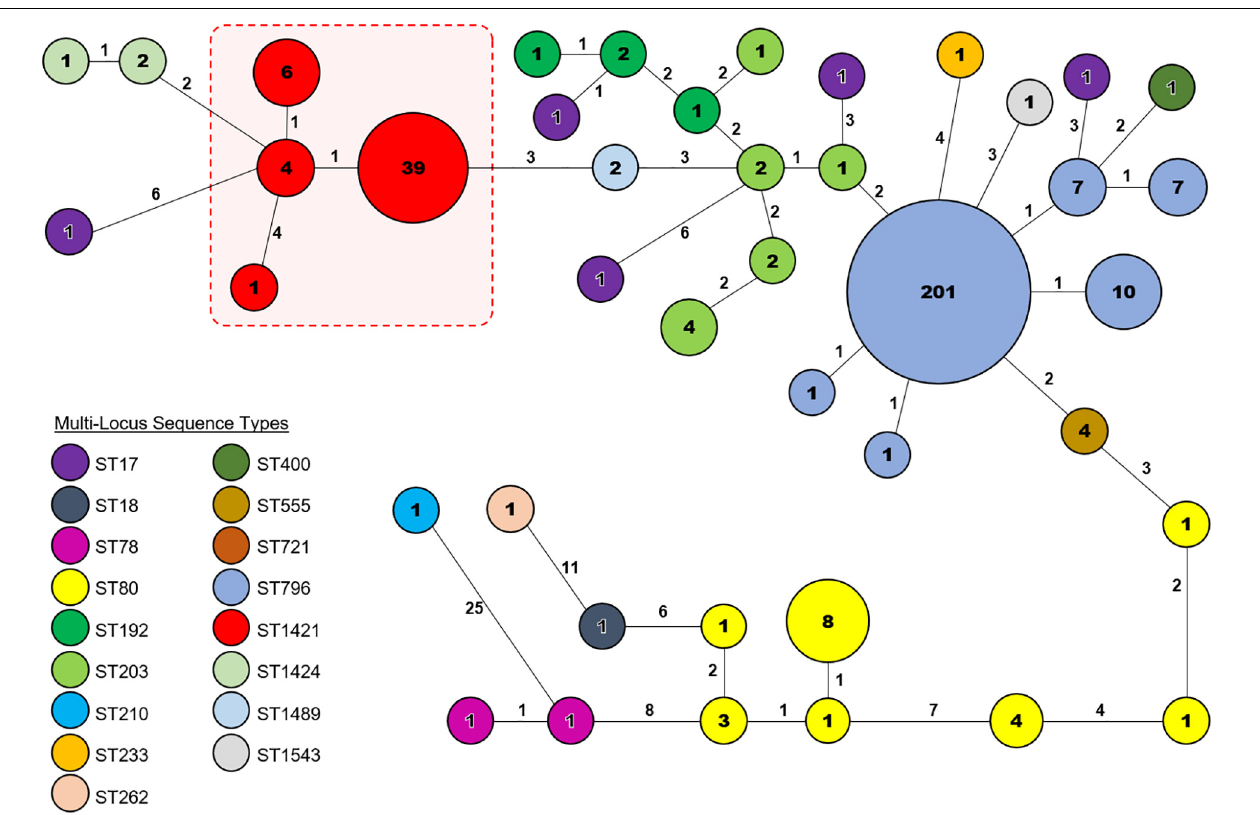
FIGURE 2 | Core genome Multi-Locus Sequence Type (cgMLST) analysis of vancomycin-resistant Enterococcus faecium (VREfm) isolates from the four public hospitals in Tasmania (RHH, Royal Hobart Hospital; LGH, Launceston General Hospital; NRH, North West Regional Hospital; MCH, Mersey Community Hospital). The isolates were analyzed using cgMLST in Ridom SeqSphere+ and are visualized in a minimum spanning tree. Isolates with zero allele differences between them grouped together in clusters with isolates per cluster shown in the circles. The number of different alleles between clusters and unique isolates is shown on the connecting lines (not to